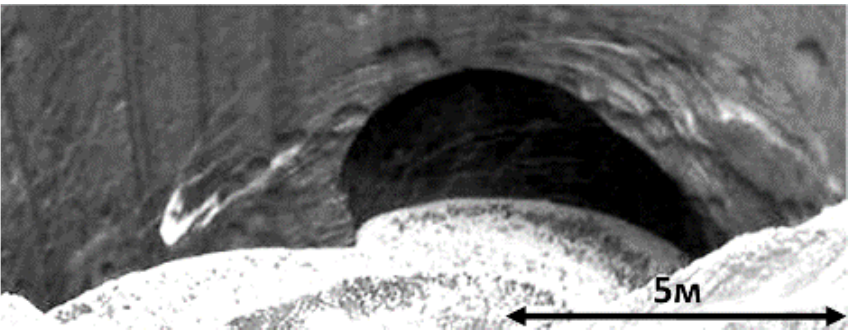
Figure 4. Deformation of primary bedding over the zone of caverns and grottoes. Plastic deformation of the ice layers shows that the pressure was applied in the frozen, and not in thawed, soils. Photo credit: V.V. Olenchenko.